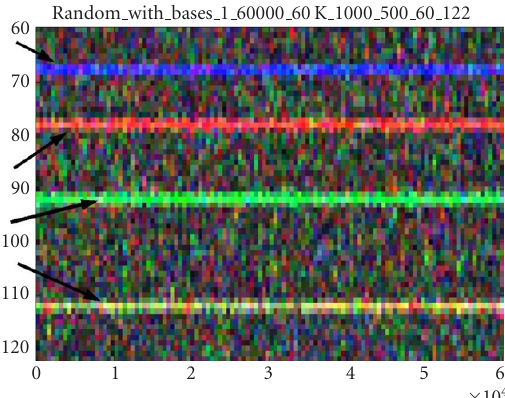
Figure 1: Spectrogram of a random DNA sequence of length 60 kbp. No obvious patterns are discernable. Spectrogram titles are annotated with a helpful name or accession tag, sequence-start in- dex, sequence-end index, approximate sequence length, DFT win- dow size, window overlap, lowest frequency shown in image, and highest frequency shown in image.